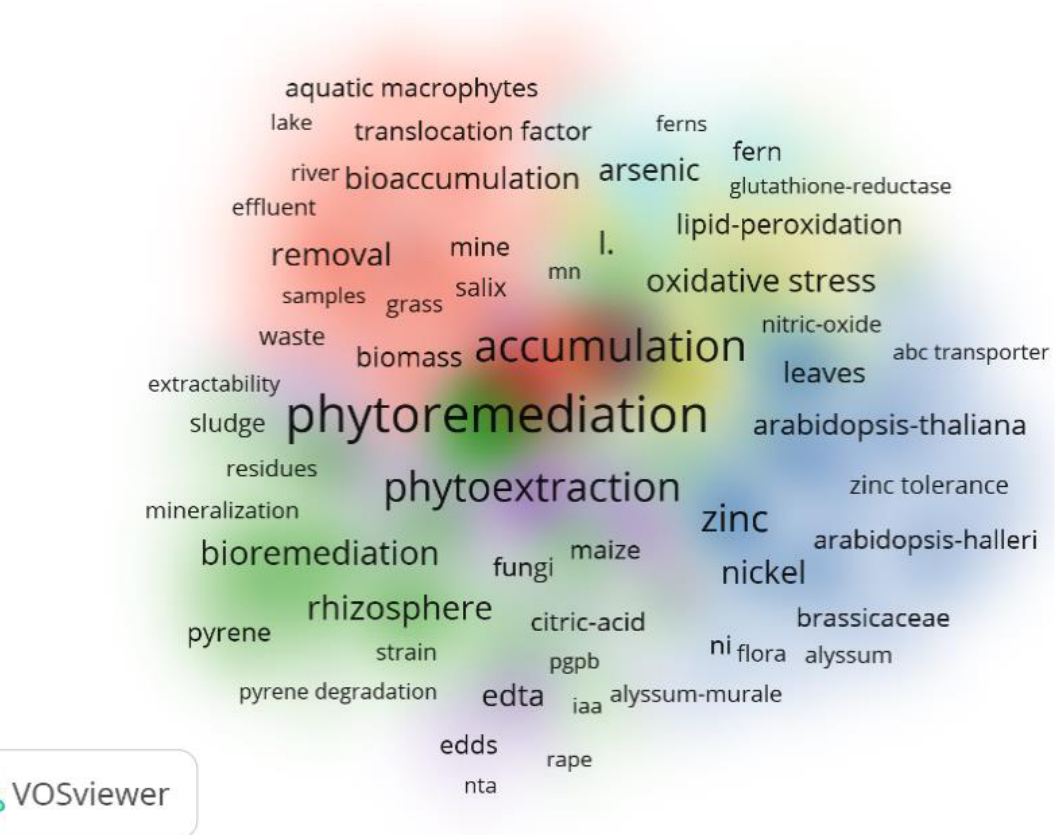
Figure 6. The density view of keyword co-occurrence. Note that a larger font for a keyword indicates a greater total link strength (TLS). The closer the keywords are to each other, the better the relevance of these topics. Note that this is produced by Vosviewer and the content cannot be